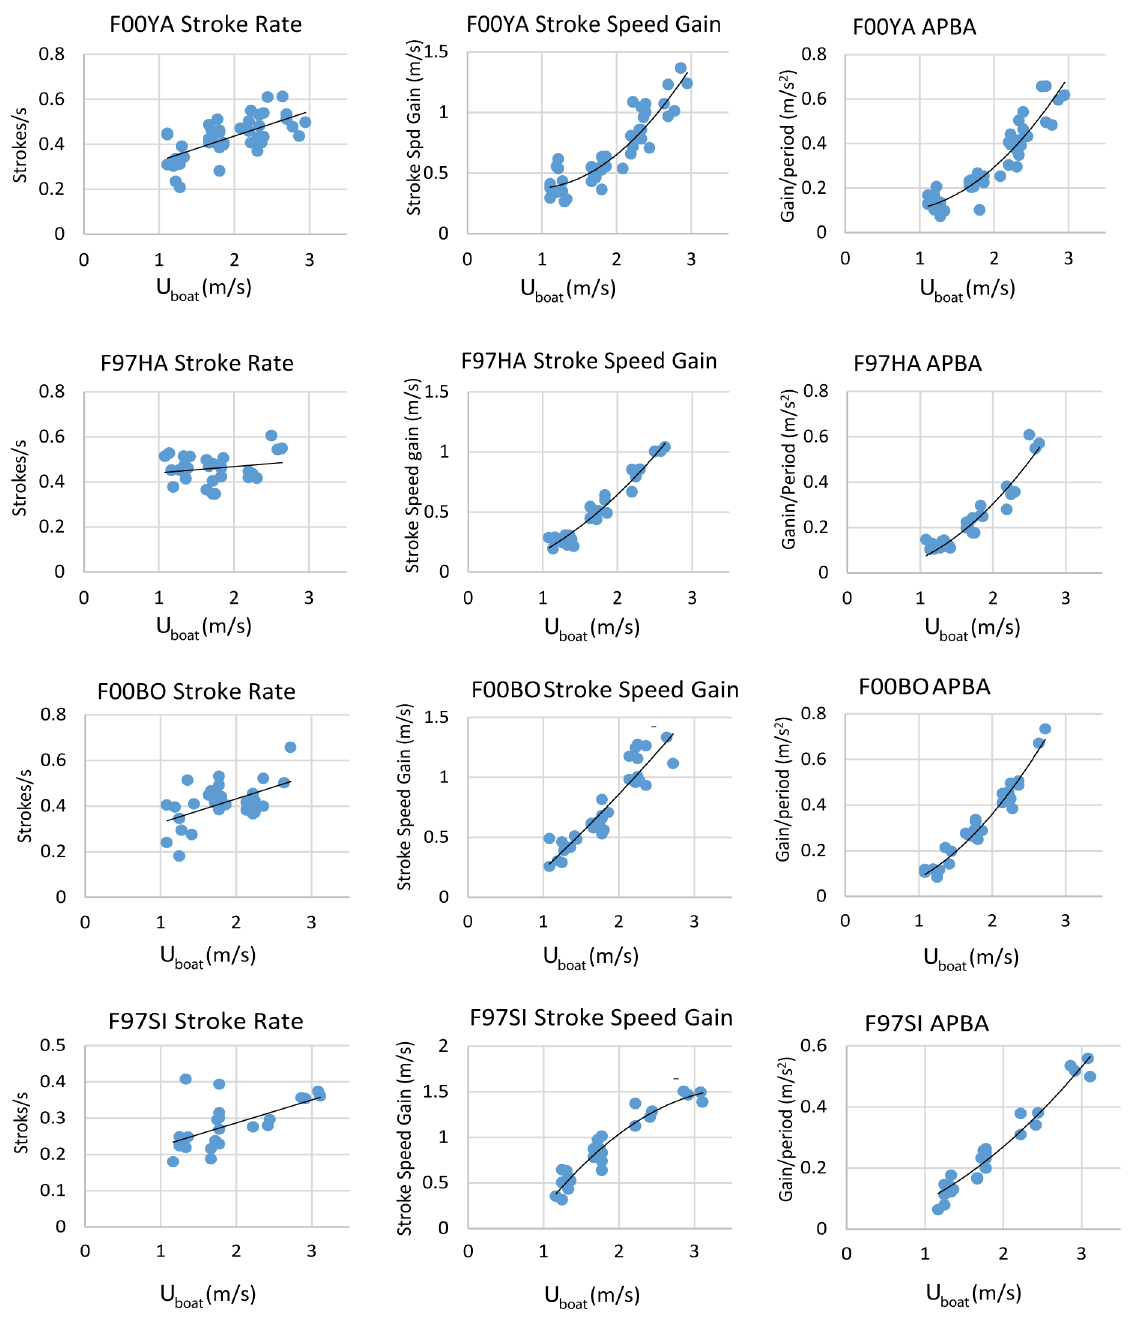
Fig 10. The left hand column illustrates the relationship between stroke rate and swimming speed for the four animals. Each point represents data from a single dive. The middle column illustrates the relationship between the average speed gain during single strokes and boat speed for the four animals. The right hand column illustrates the relationship between the stroke speed gain multiplied by the stroke rate (APBA).